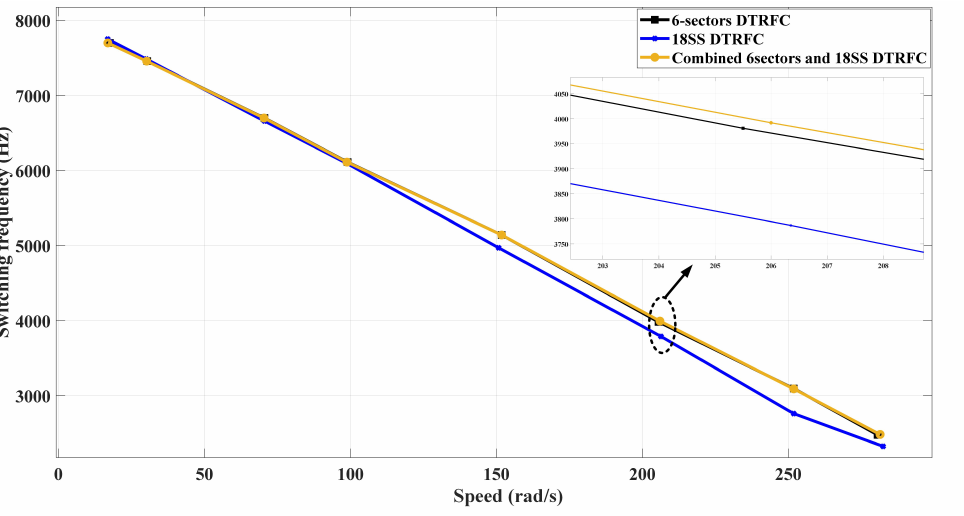
Figure 24. The switching frequency of the conventional and proposed strategies over the speed range. It is noticed that the switching frequency values are high at low rotational